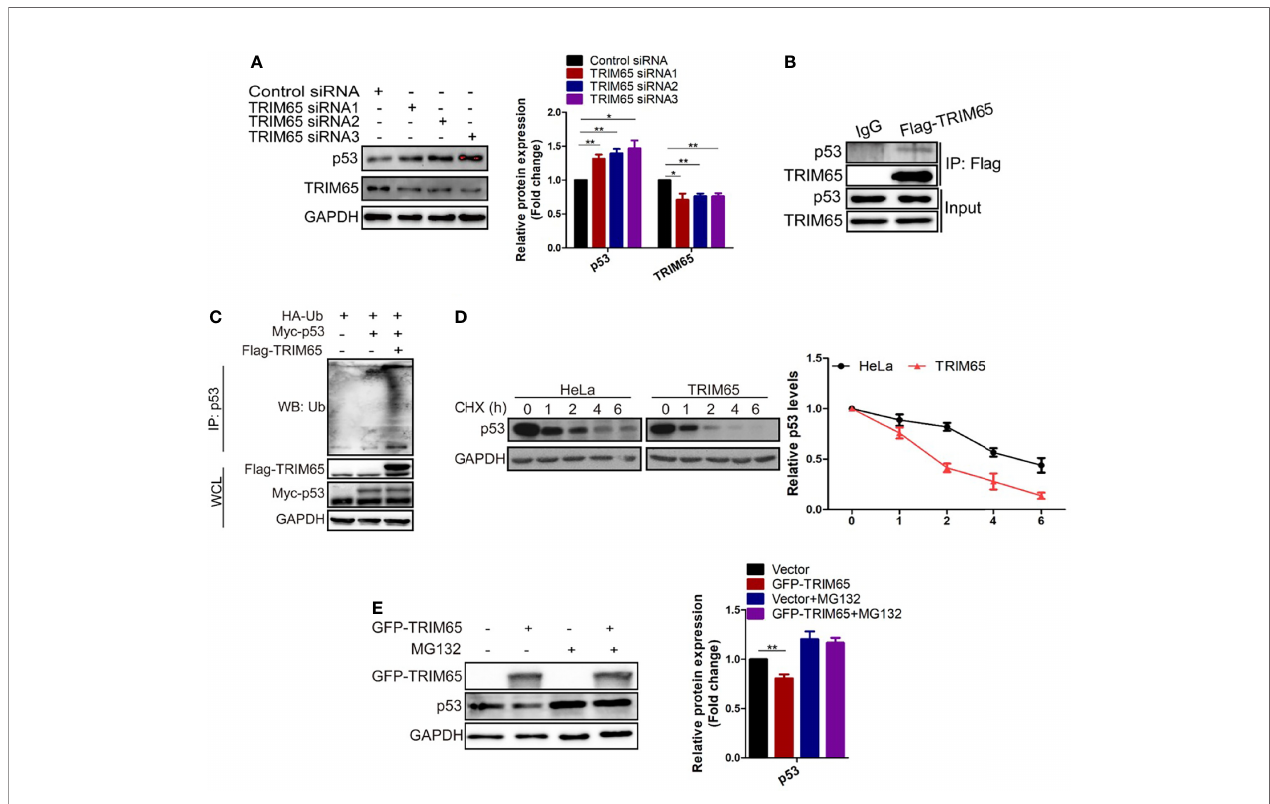
FIGURE 5 | TRIM65 promotes ubiquitination and degradation of p53. (A) Western blot analysis of the expression levels of p53 in HeLa cells with TRIM65 knockdown. GAPDH was used as a loading control. Relative protein expression over GAPDH was quanti fi ed, and the statistical data was shown (Right panel). (B) IP and western blot analysis of the interaction of Flag-TRIM65 with p53 in the lysates of HeLa. (C) Cells were co-transfected with p53 plus HA-ubiquitin and/or Flag-TRIM65 as indicated. Then the cell lysates were immunoprecipitated with p53 antibody, the ubiquitination was detected using anti-ubiquitin antibody. (D) HeLa cells were transfected with vector plasmid or TRIM65 and treated with 25 m g/ml CHX for different time points, followed by western blot analysis (Top panel). The related protein levels at the indicated treatment times (Bottom panel). (E) HeLa cells with TRIM65 overexpression were treated with or without MG132, and then immunoblotted with antibodies against p53. Relative protein expression over GAPDH was quanti fi ed, and the statistical data was shown (Right panel). Data are presented as mean ± SD. The experiments were repeated three times independently and the data of one representative experiment was shown. *p < 0.05; **p <